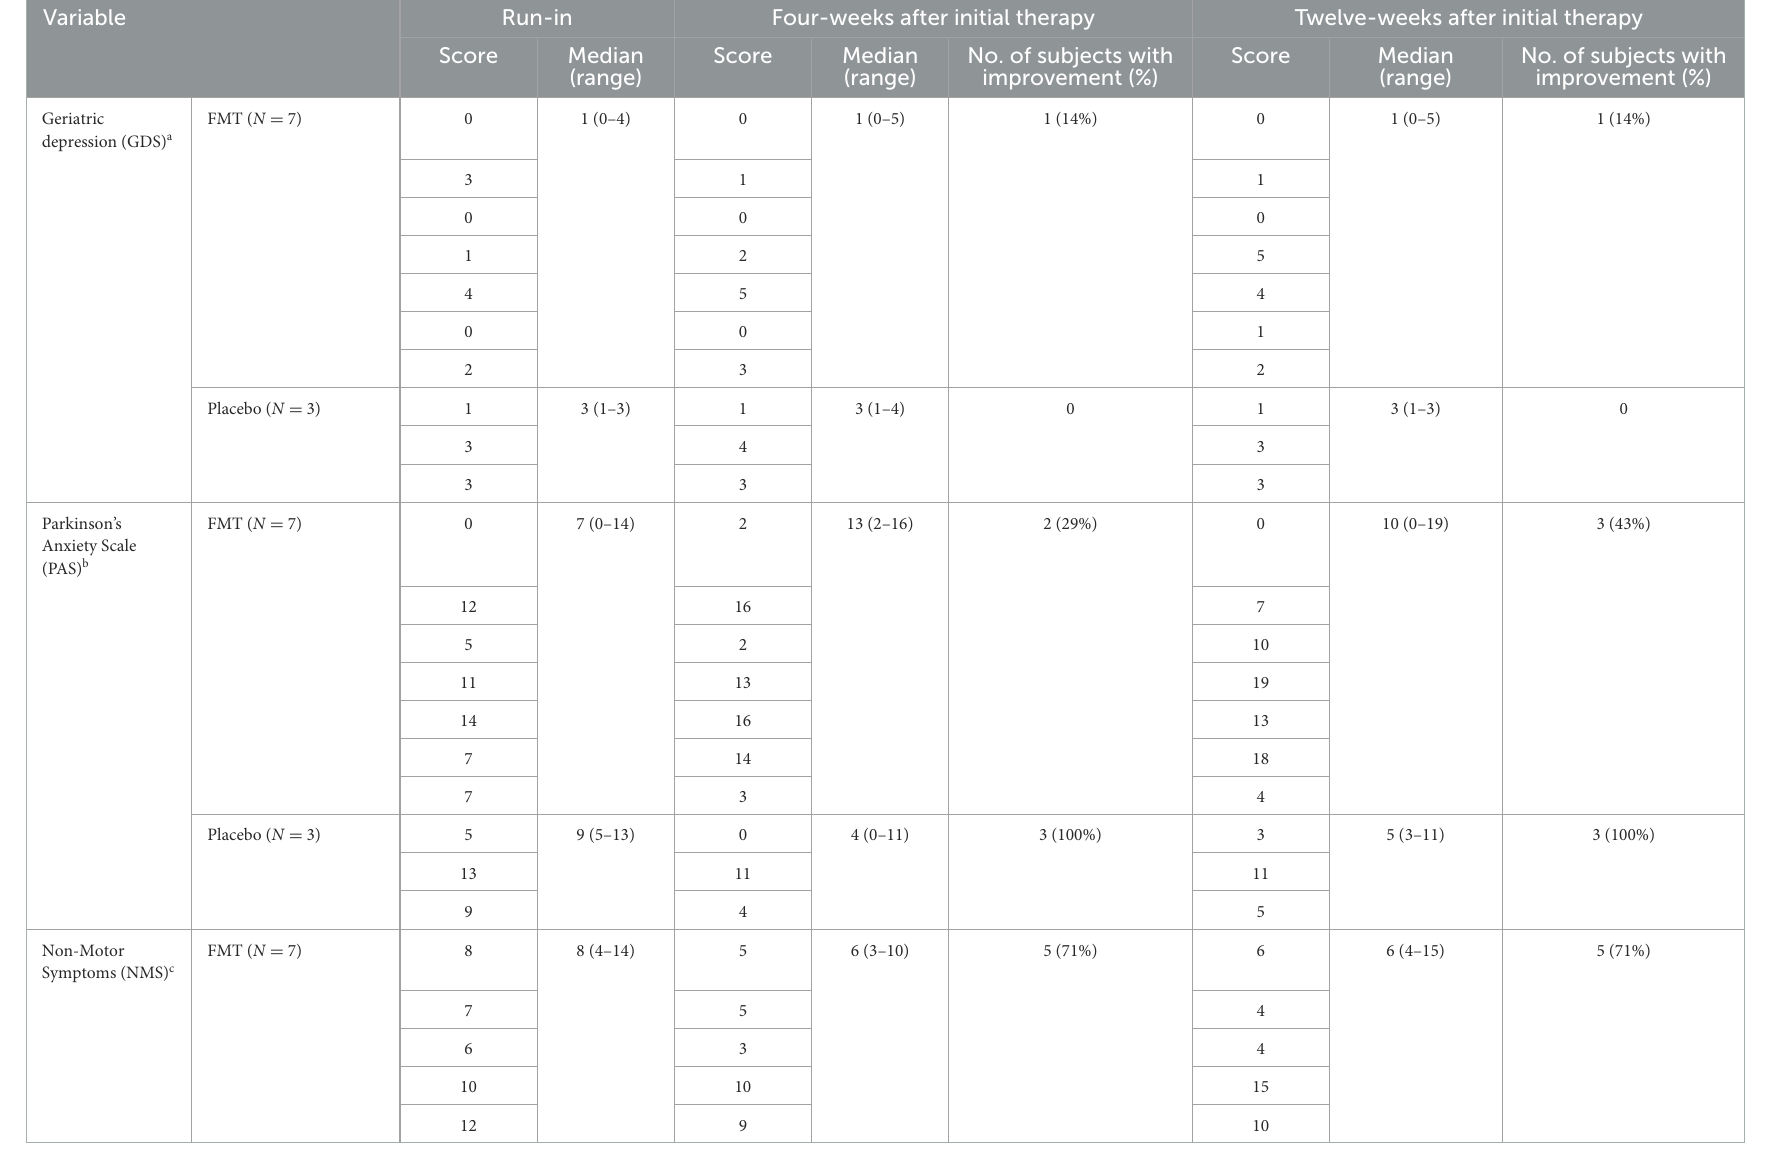
TABLE 3 Questionnaire scores at 4-weeks and 12-weeks after randomization to FMT ( N = 7) or placebo ( N = 4) in subjects with Parkinson’s disease failing to show improvement after 12-weeks of FMT.